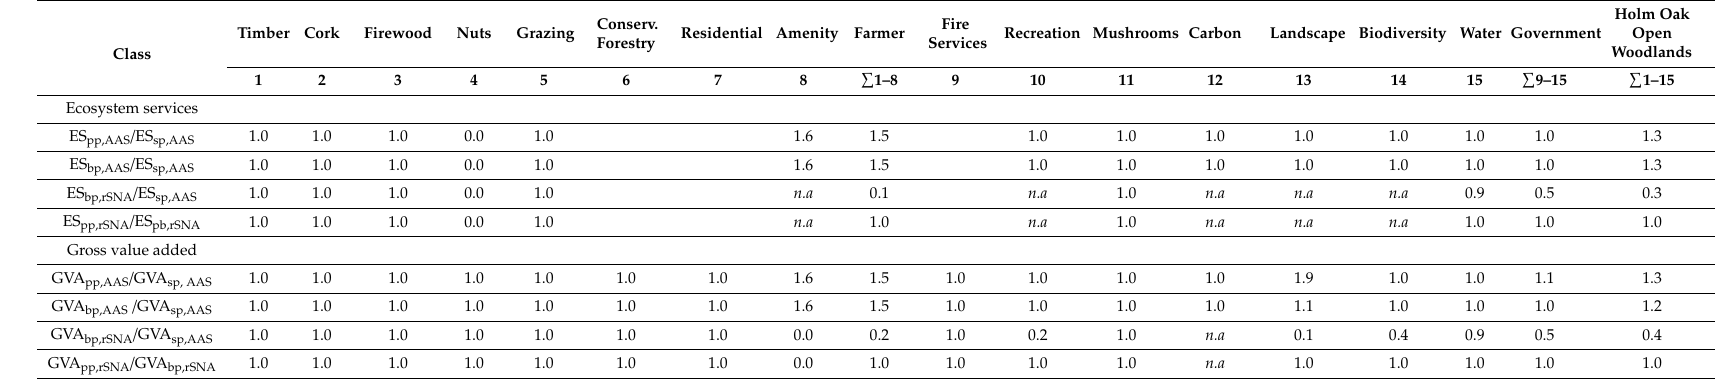
Table 4. Agroforestry Accounting System and refined standard System of National Accounts ecosystem services and gross value-added index comparisons for holm oak open woodlands in Andalusia